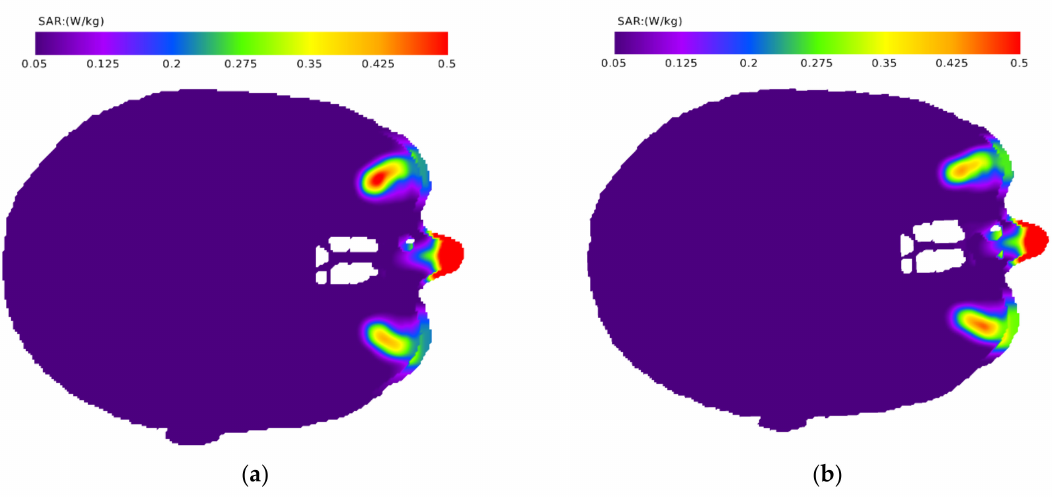
Figure 15. SAR averaged in 1 g of tissue mass simulated for 3600 MHz: ( a ) no shield and ( b ) with metal surface shield.